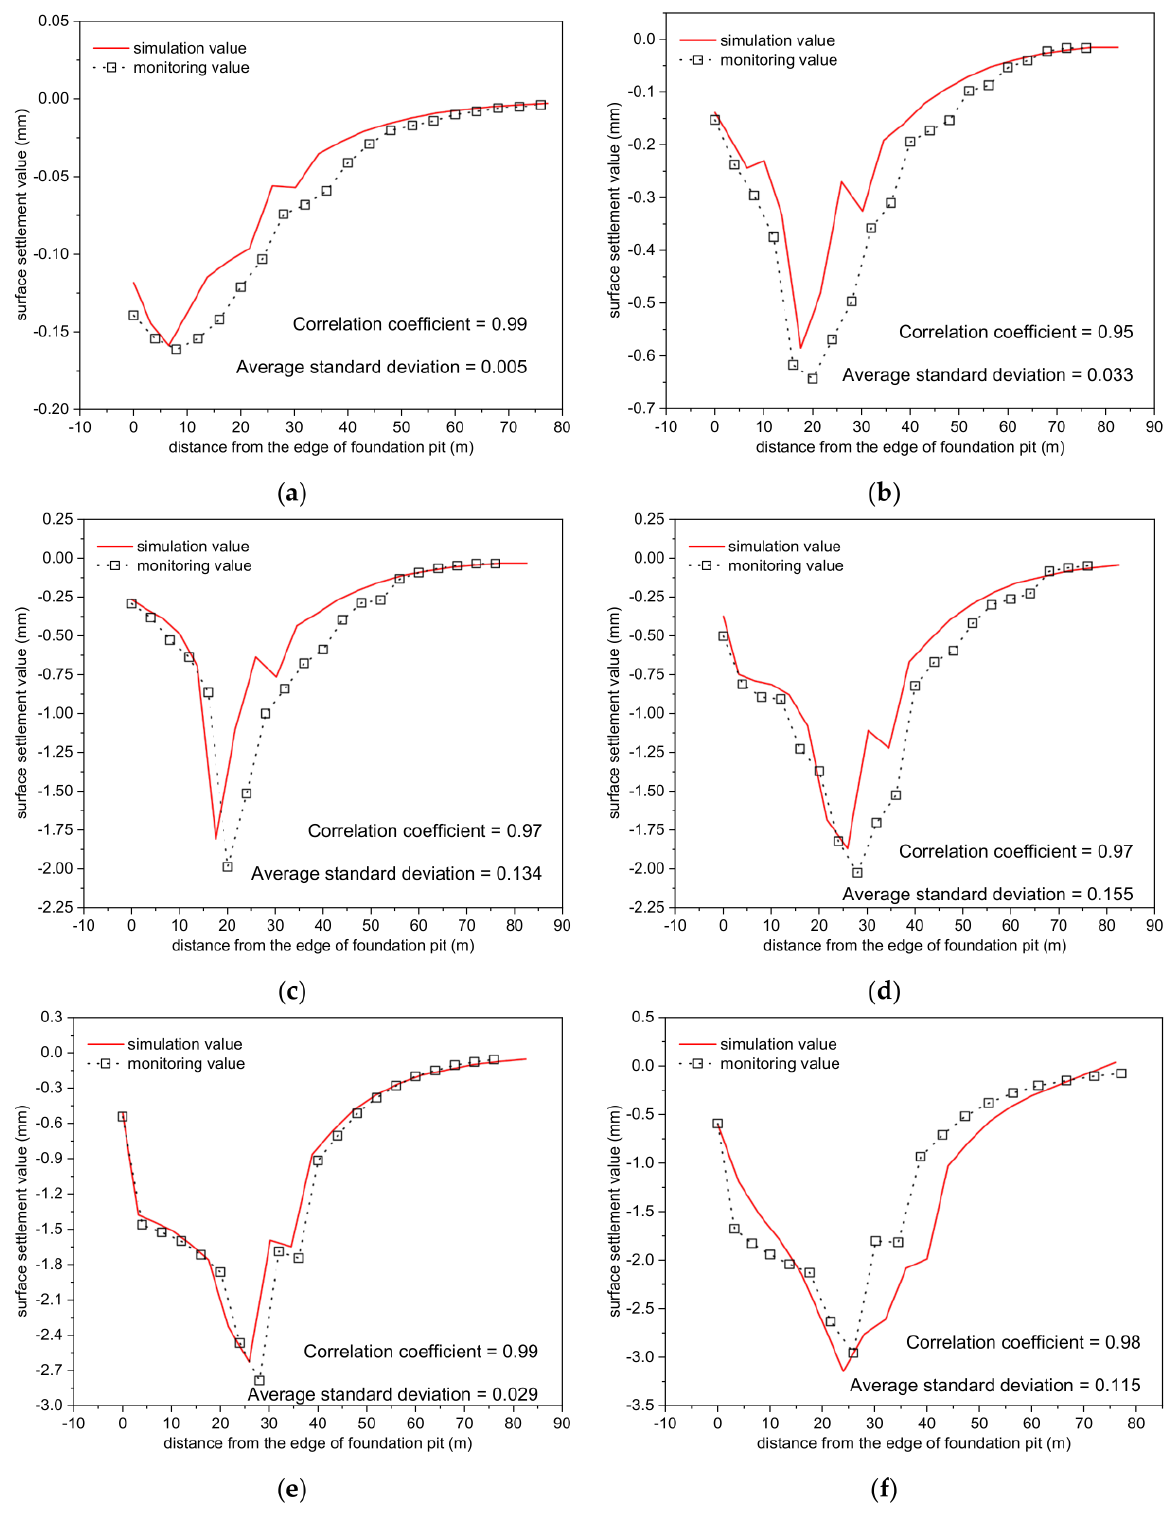
Figure 10. Comparison of surface settlement value under various excavation conditions. ( a ) step 1; ( b ) step 2; ( c ) step 3; ( d ) step 4; ( e ) step 5; ( f ) step 6.